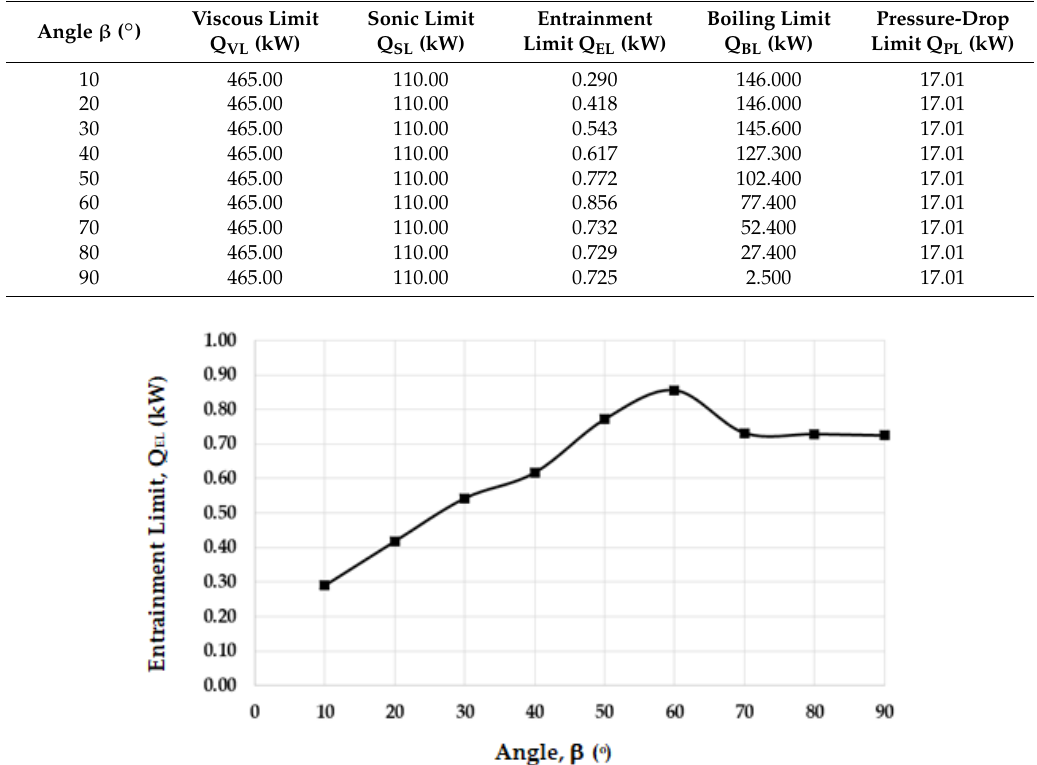
Table 6. Impact of the evaporator inclination angle.